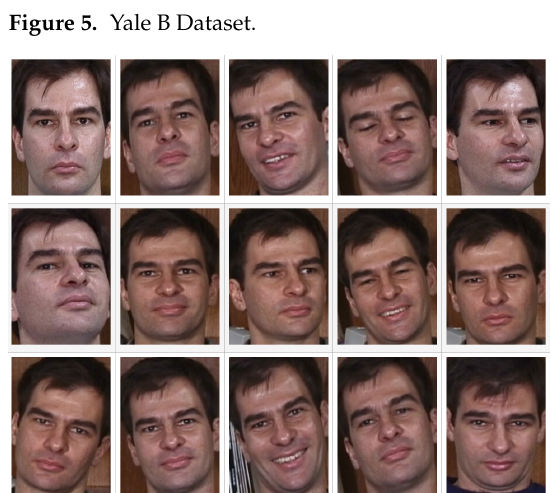
Figure 6. Georgia Tech Dataset.